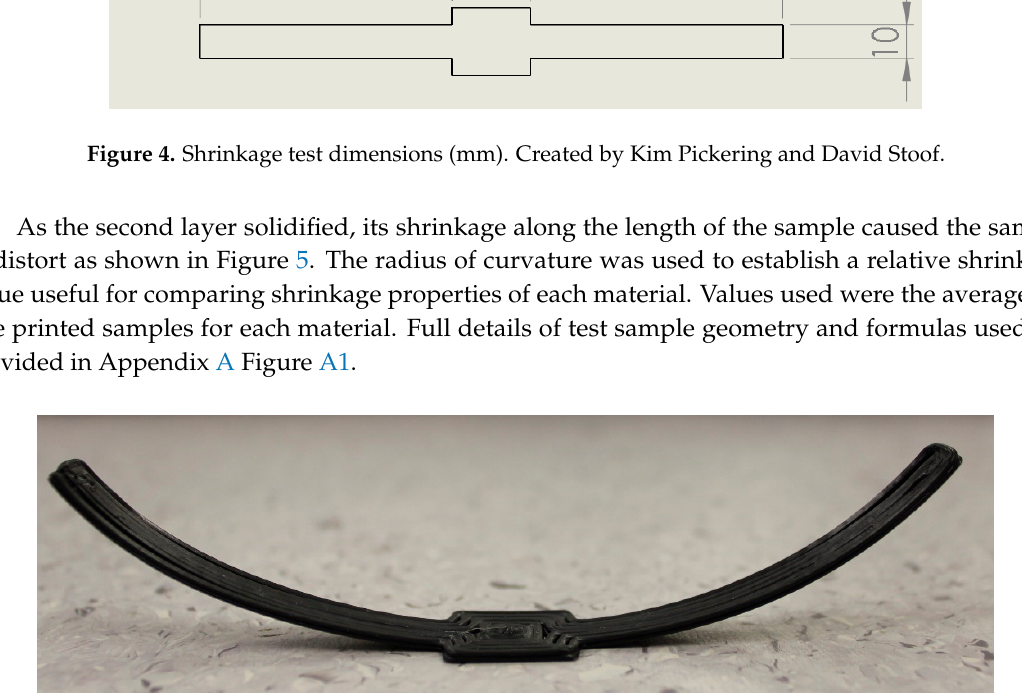
Figure 5. 3D printed polypropylene (PP) shrinkage test sample. Created by Kim Pickering and David Stoof.